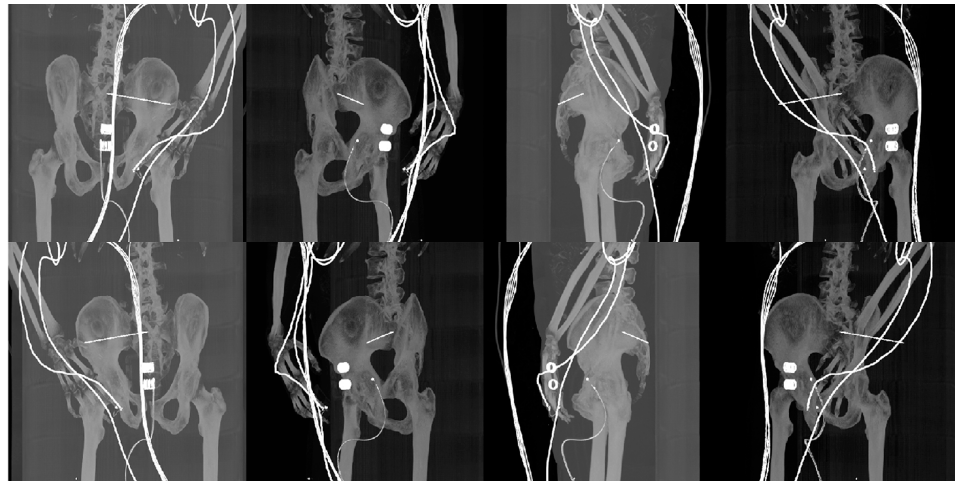
Figure 5. Generated series of DRR projections with rotations per 45°.